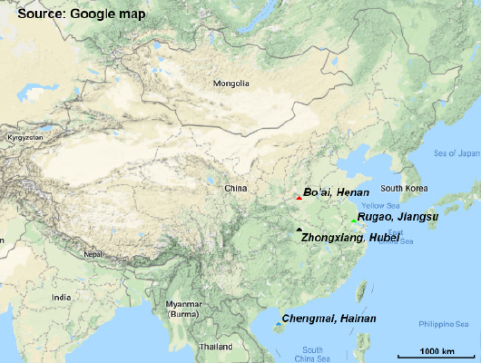
Figure 1. Sampling sites in this study. The four sampling sites are represented by colored triangles on the map. Red: Bo’ai (Henan Province); Green: Rugao (Jiangsu Province); Black: Zhongxiang (Hubei); Blue: Chengmai (Hainan Province).